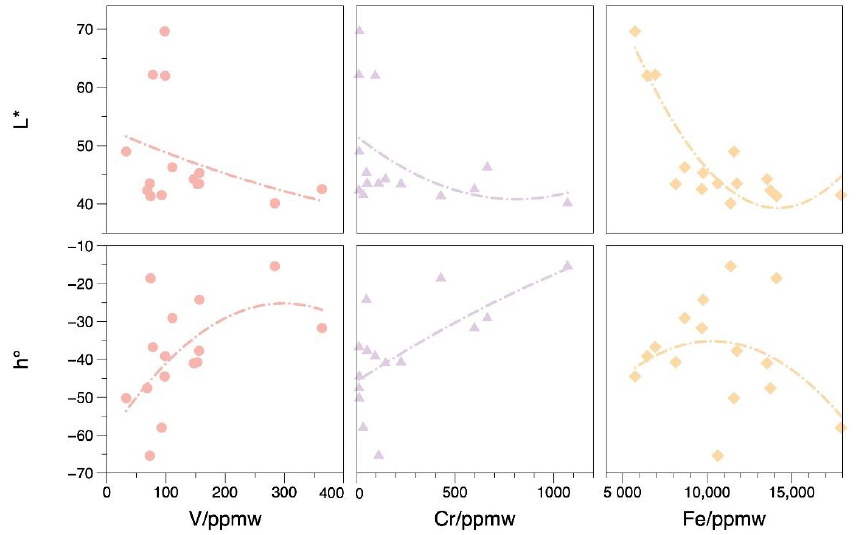
Figure 15. The relationship between vanadium/chromium/iron and the lightness/hue angle in Tanzanian spinels.